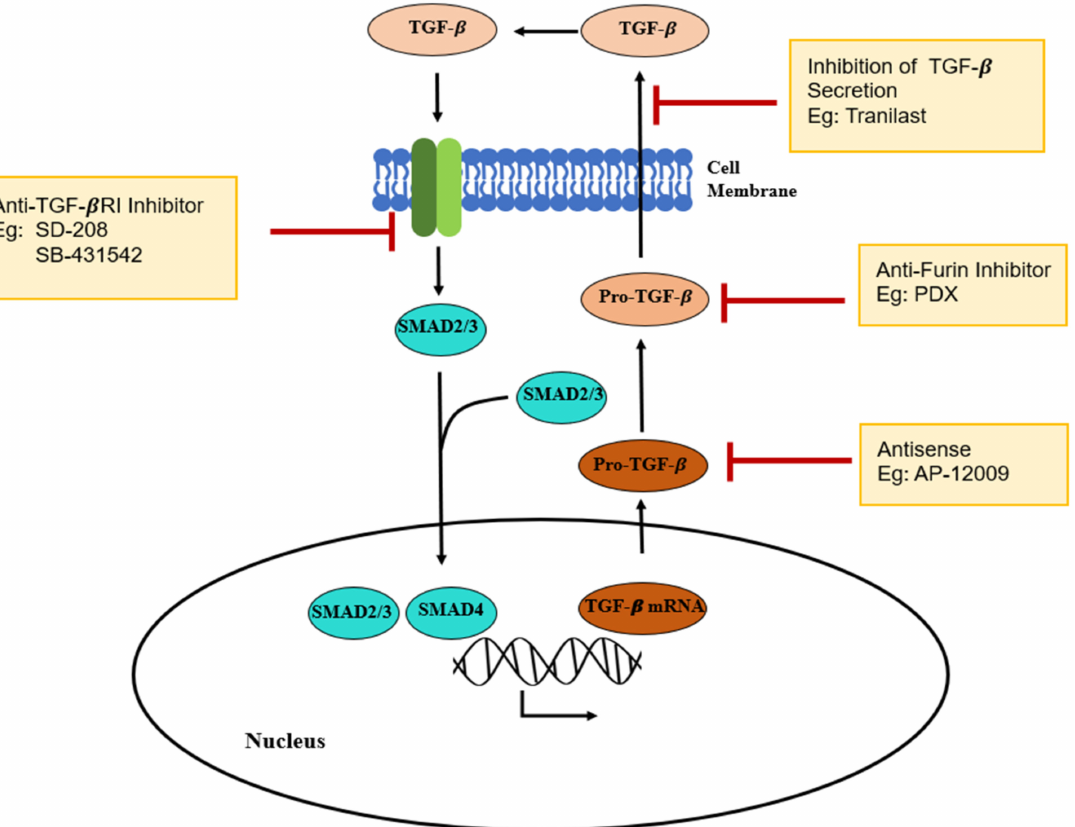
Figure 6. Molecular mechanism of tranilast action. TGF- β is responsible for prolonged inflammation and causes the fibrous capsule formation. Tranilast plays a role as an inhibitor of TGF- β . Reproduced with permission from